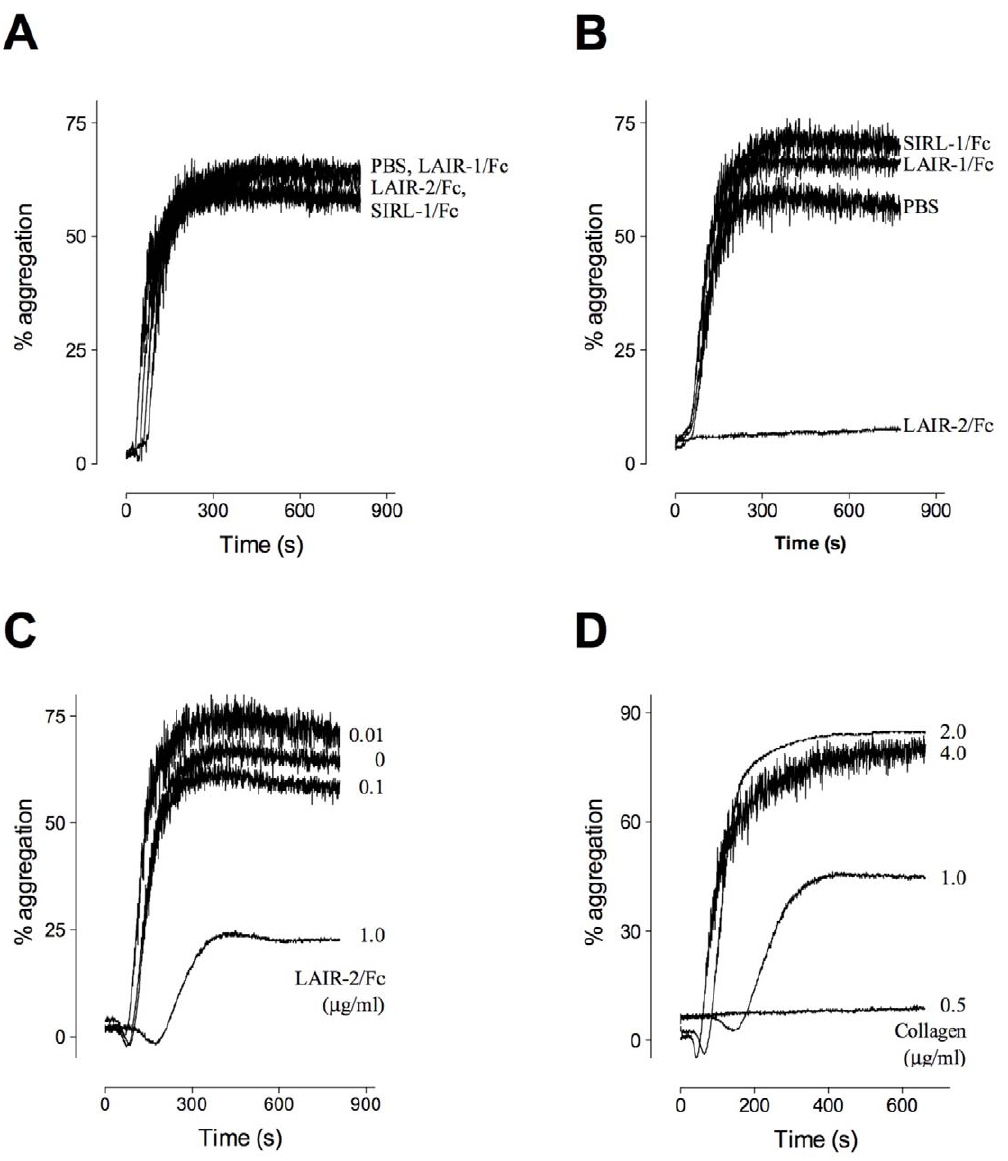
Figure 2. LAIR-2/Fc inhibits collagen but not TRAP-induced platelet aggregation. Aggregation of platelet rich plasma (PRP) in response to collagen was measured using an optical aggregometer. Panel A: Platelet aggregation in response to 50 m M TRAP alone (PBS) or in the presence of 100 m g/ml LAIR-1/Fc, LAIR-2/Fc or SIRL-1/Fc. Panel B: Platelet aggregation in response to collagen (1 m g/ml) alone (PBS) or in the presence of 100 m g/ ml LAIR-1/F, LAIR-2/Fc or SIRL-1/Fc. Panel C: Platelet aggregation in response to collagen (1 m g/ml) alone (PBS) or in the presence of 0.01 m g/ml, 0.1 m g/ml or 1.0 m g/ml LAIR-2/Fc. Panel D: Platelet aggregation in response to 0.5 m g/ml, 1 m g/ml, 2 m g/ml or 4 m g/ml collagen in the presence of 1.0 m g/ml